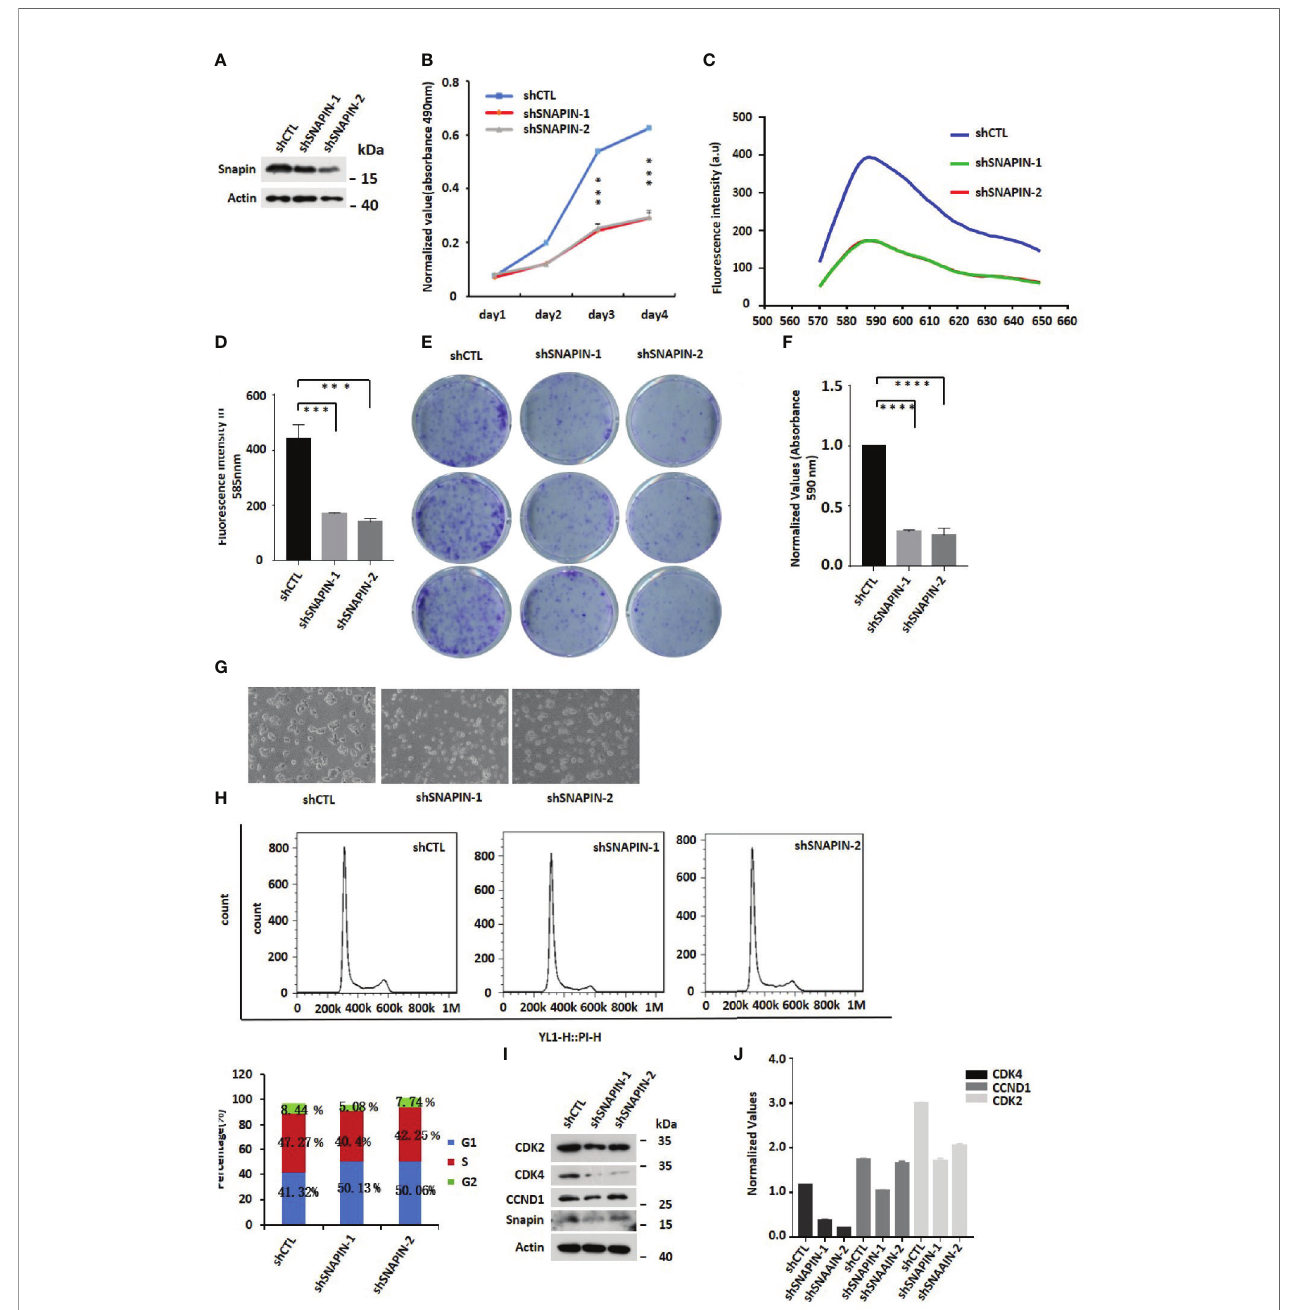
FIGURE 5 | SNAPIN knockdown inhibit proliferation of b cells. (A) Mouse Min6 cells were transduced with lentivirus expressing shRNA and non-speci fi c sequences. A signi fi cant decrease in SNAPIN protein by Western blot analysis. (B) MTS analysis illustrated that the proliferation of Min6 cells were inhibited after SNAPIN knockdown. (C) Click-iT ™ EdU Proliferation Assay illustrated that the proliferation of Min6 cells were inhibited after SNAPIN knockdown. (D) Statistic for fl uorescence intensity in 585nm. (E) Clone formation showed that SNAPIN knockdown inhibited the proliferation of b cells. (F) Statistic for clone formation. (G) Cell photography indicates Min6 cells suffer death with SNAPIN knockdown. (H) The cells were stained with PI staining. Adherent cells were collected, and cell cycle analysis was done by fl ow cytometry. SNAPIN knockdown resulted in a decrease in the population of cells in S phase. (I) The protein expression levels of CyclinD1, CDK2 and CDK4 were checked by Western blot with indicated antibodies. (J) Normalized histograms of snapin protein against actin by using imaging software. *P < 0.05, **P < 0.01, *** P< 0.001, ****P <